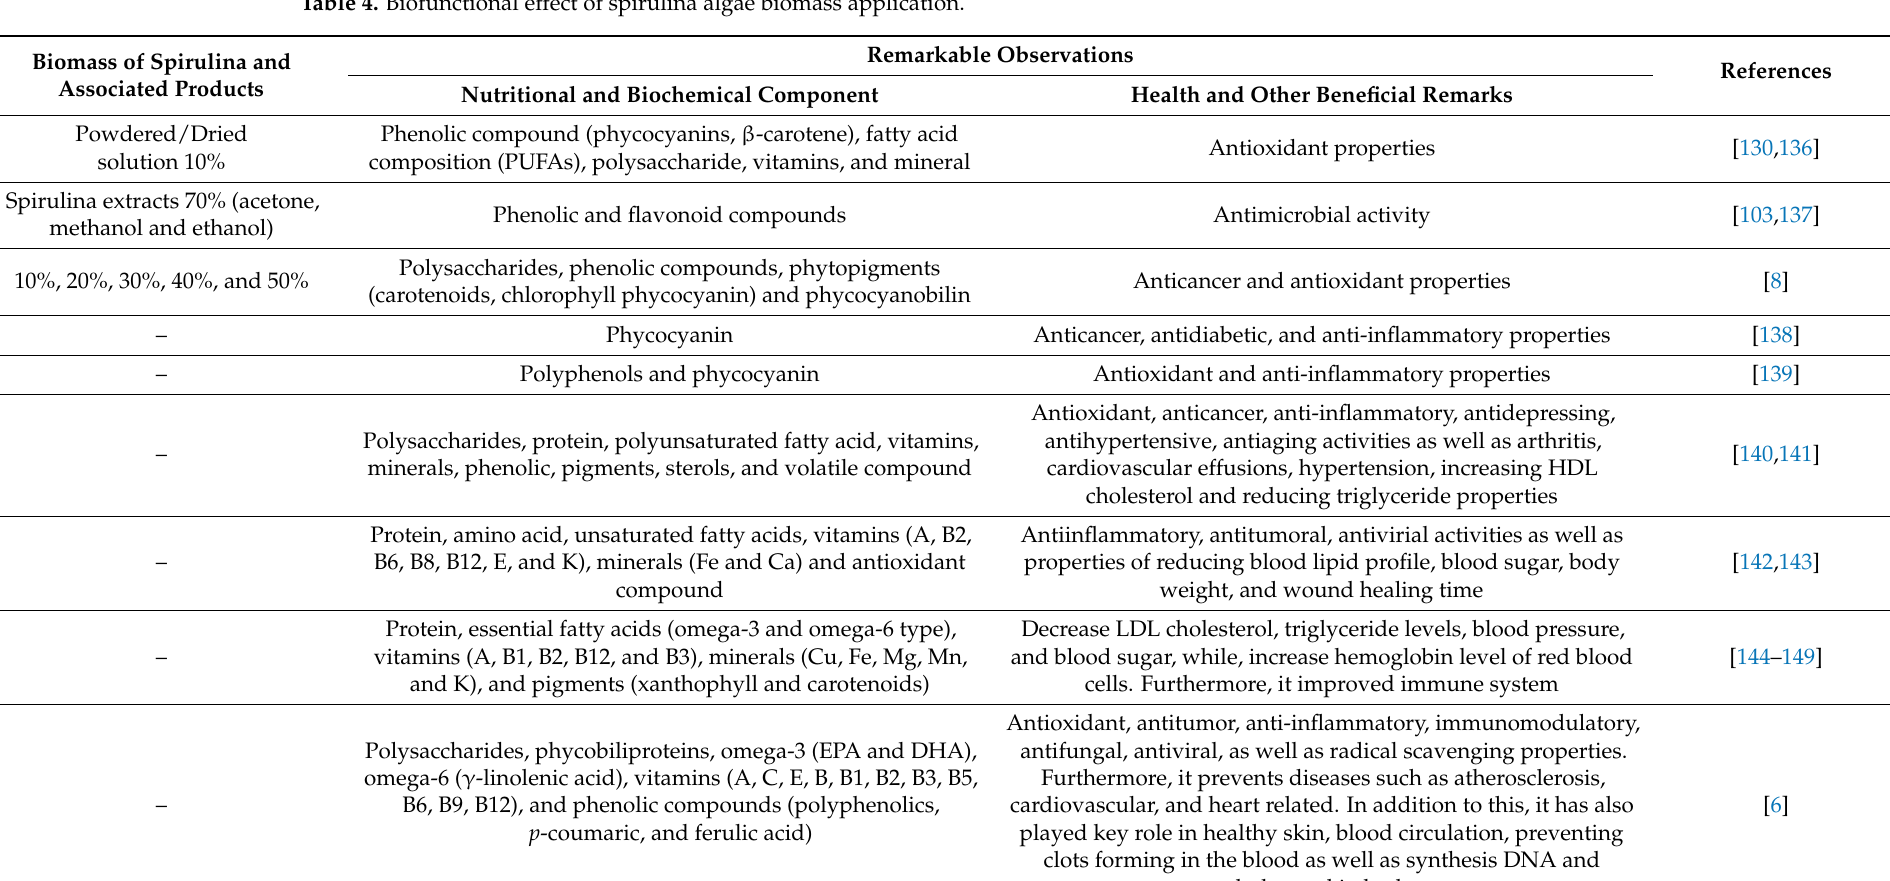
Table 4. Biofunctional effect of spirulina algae biomass